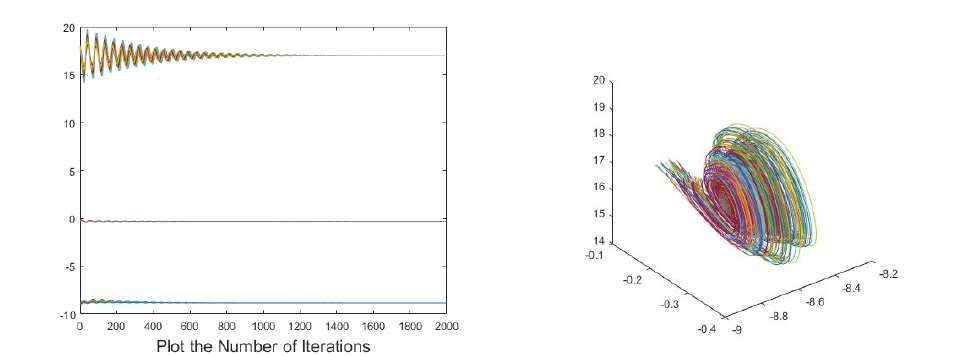
Fig. 7 Left: Locally asymptotically stable trajectories and in Right: the 3D plot of the trajectories of the equilibrium point ( − 8 . 84531 , − 0 . 315904 , 17 ) where the initial values are taken from the neighbourhood of the origin. For the system D 52 , 41 , 9 [ 15 ] , the eigenvalues are 17 . 7339 + 231 . 063 i , 17 . 7339 − 231 . 063 i , − 96 . 4679 where real part of the eigenvalues are not all negative and hence the equilibrium point ( 3 . 65333 , 0 . 405925 , 41 ) is unstable. The trajectories are shown in Fig.8 with many initial values taken from the neighbourhood of the equilibrium point ( 3 . 65333 , 0 . 405925 , 41 ) .